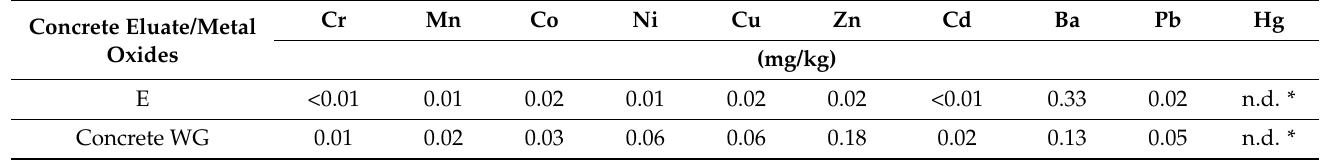
Table 7. Contents of potentially hazardous metals in concrete eluates.